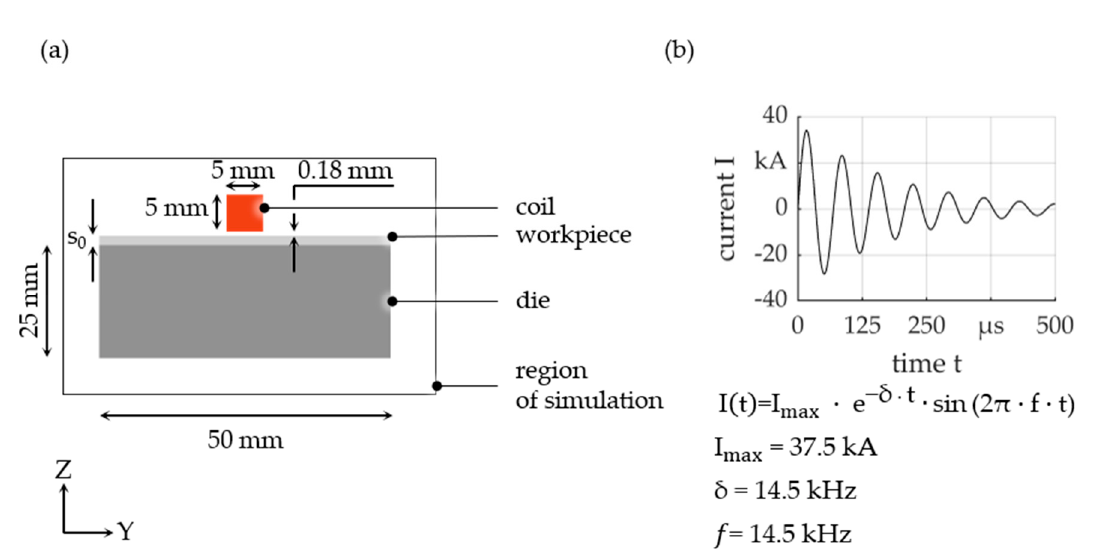
Figure 1. Simulation model; ( a ) schematic; ( b ) input current (tool coil).